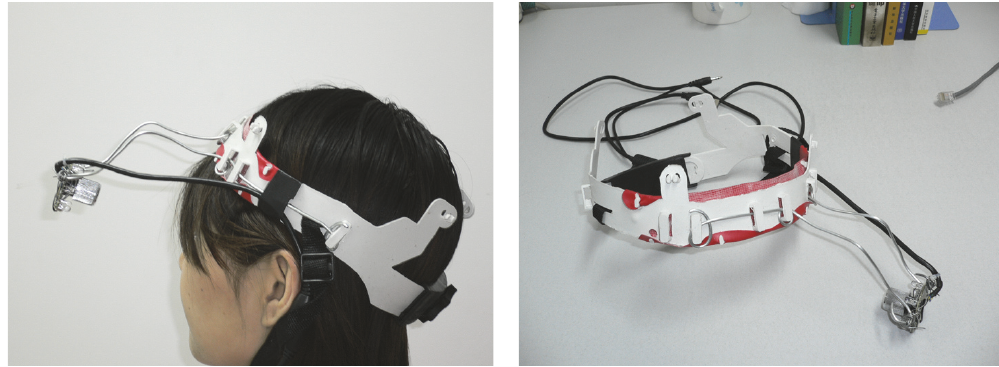
Figure 2: Head mounted device.